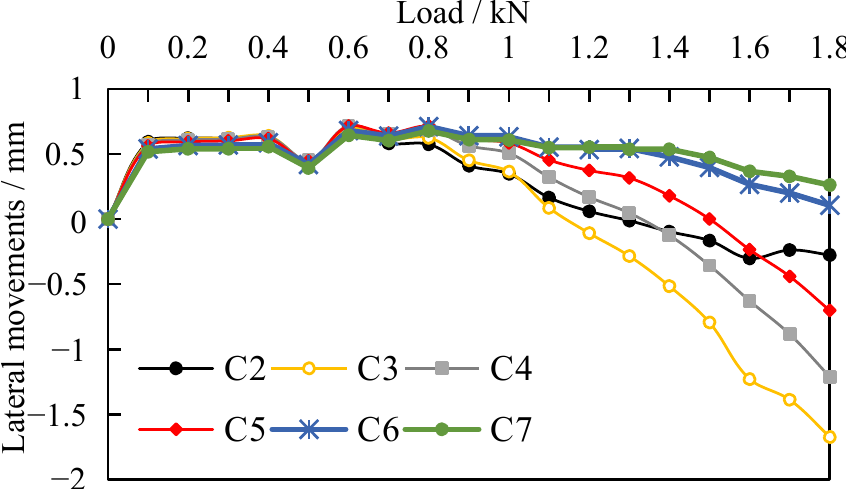
Figure 9. The horizontal displacement of each point on the C-axis.